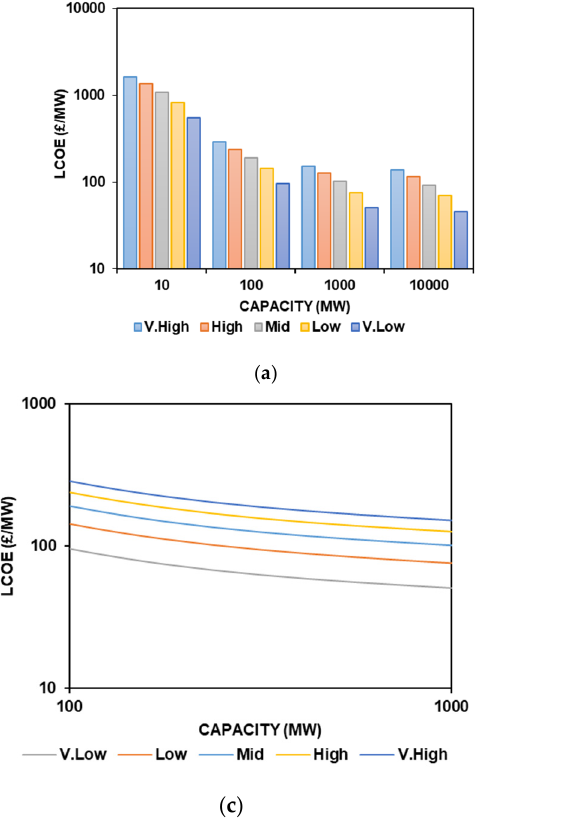
Figure 4. ( a ) 25 Year Case Scenarios; ( b ) Scenario distribution; ( c ) Enhanced distribution; and ( d ) Generational capacity.